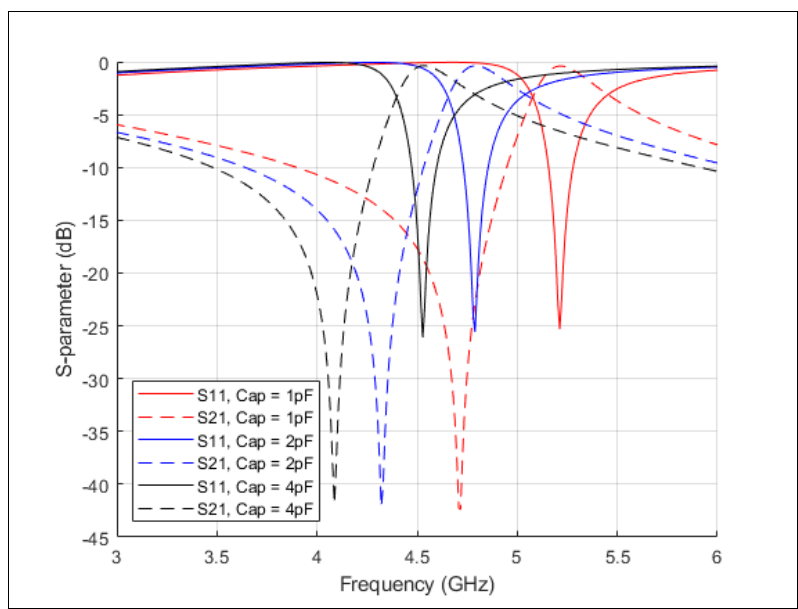
Figure 8. Passband variation with changes to the effective capacitance value of the